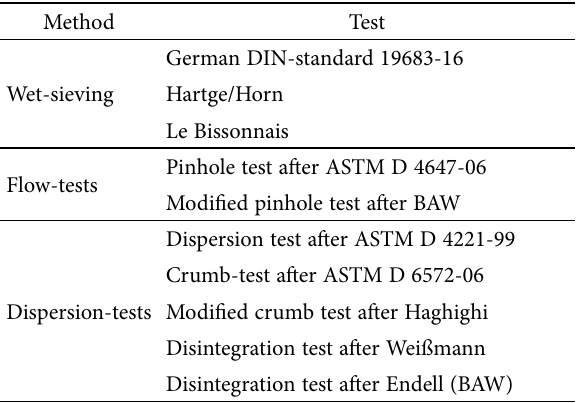
Table 1. Overview of tests to determine aggregate